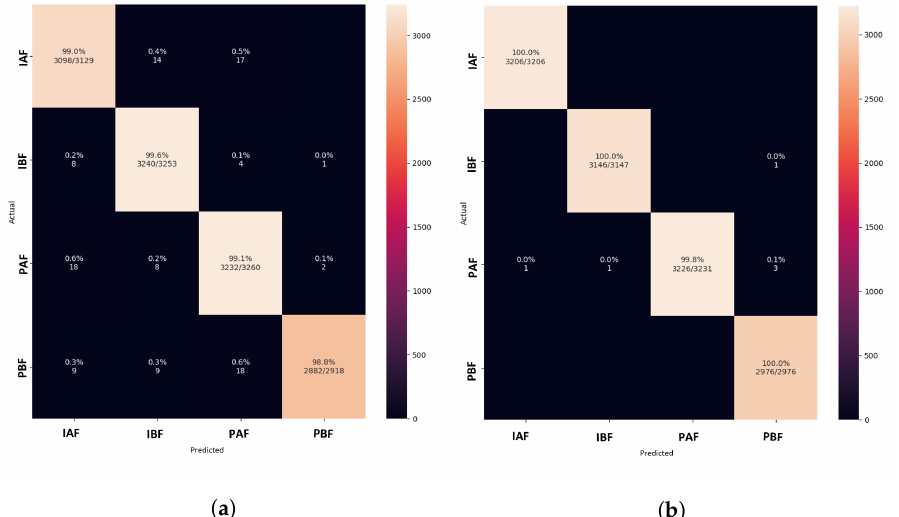
Figure 14. Confusion matrix of modified CNN models for learning rate = 0.001. ( a ) CNN-LeakyReLU.